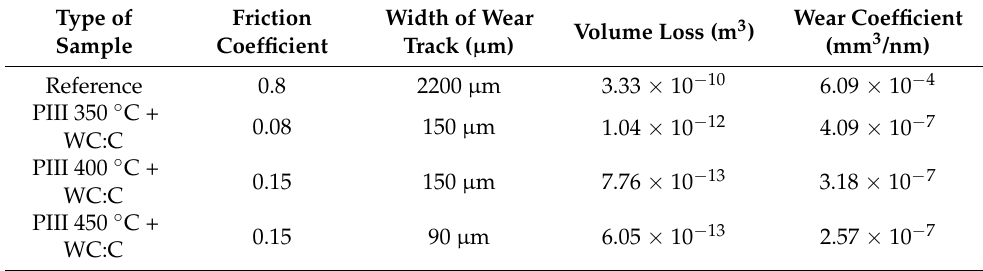
Table 9. Summary of the experimental data for the volume loss and wear coefficient measured by confocal microscope for the reference and DLC WC:C coating.